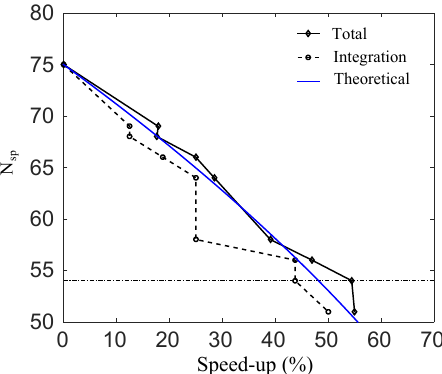
Figure 3. Number of species plotted against the percentage speed- up for the total simulation time, and for integrating Eq. (7) alone.